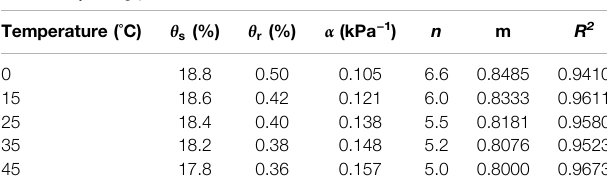
TABLE 3 | Fitting parameters of